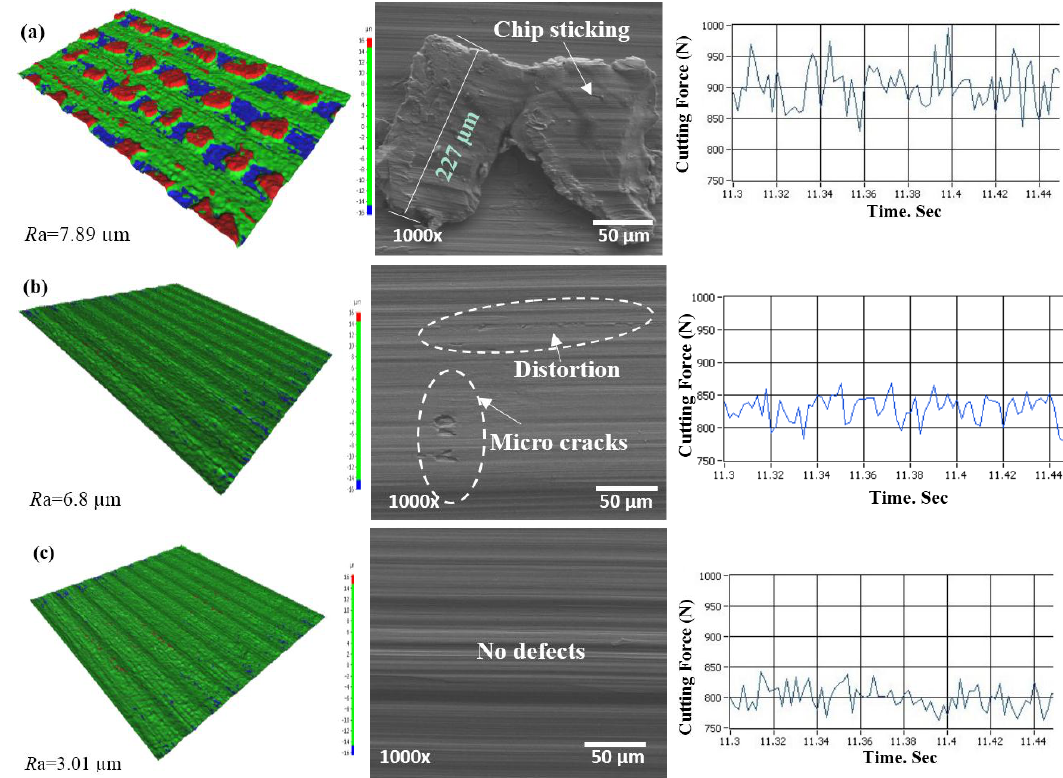
Figure 10. Three dimensional and SEM images of the machined surface obtained by ( a ) uncoated insert; ( b ) TiCN + Al 2 O 3 ; ( c ) AlTiN insert and corresponding cutting forces and surface roughness values.